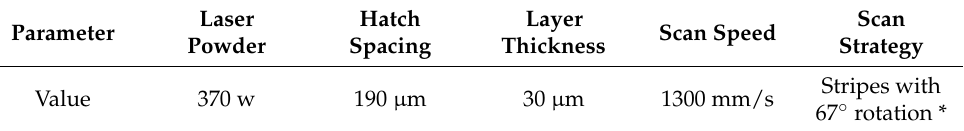
Table 1. L-PBF process parameters employed to produce the various test specimens in the study. Laser Hatch Layer Parameter Scan Speed Scan Strategy Powder Spacing Thickness Value 370 w 190 μm 30 μm 1300 mm/s Stripes with 67 ◦ rotation * *—Stripe width of 7 mm and 20 μm overlap between stripes.